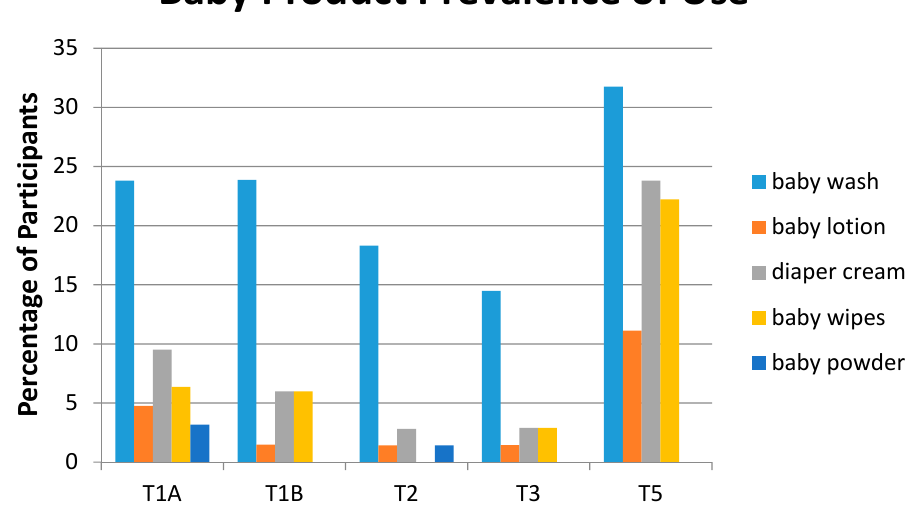
Figure 5. Prevalence of baby product use by study time period. Percentage of participants reporting use of the product at least once by study period.